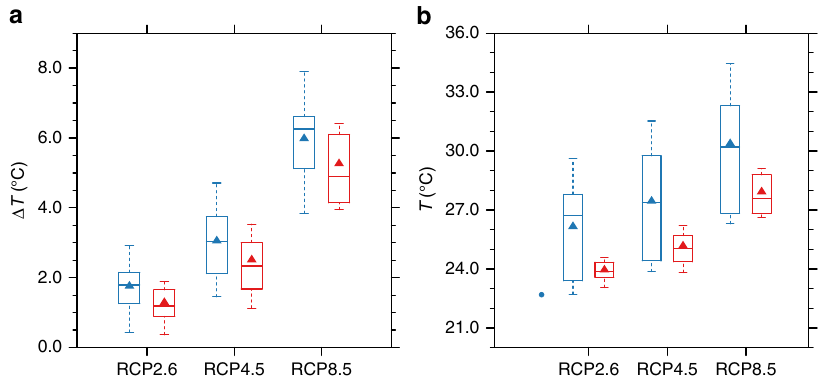
Fig. 6 Bias correction for temperature. a Boxplot of temperature changes with (red)/without (blue) bias correction for the three scenarios. b As in a but for absolute temperature. Solid dots in the fi rst columns represent the observations (averaged over 1980 – 1999). The boxes indicate 10%-quantile, 25%- quantile, median, 75%-quantile, and 90%-quantile, respectively. Solid triangles stand for the respective